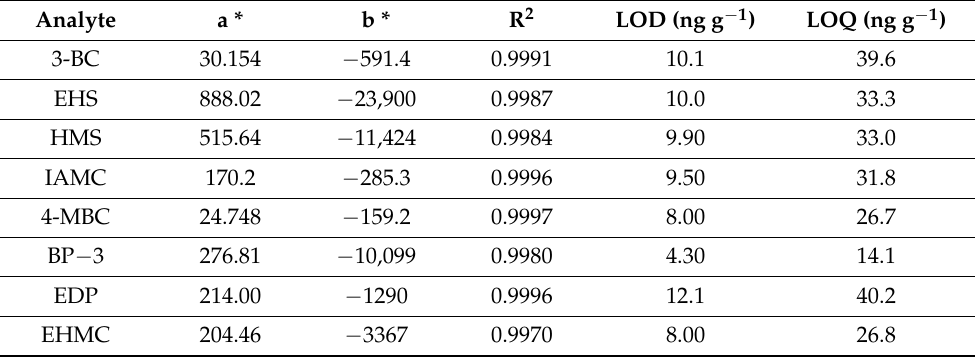
Table 3. Analytical merits of the GC – MS/MS method coupled with QuEChERS for UVF determina- tion in sludge samples.